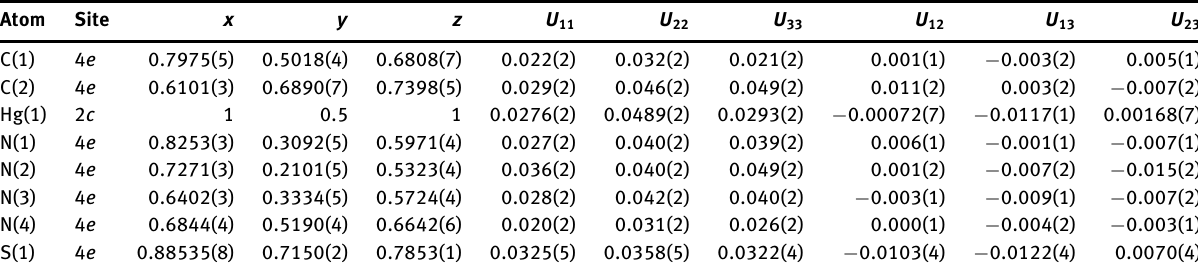
Table 3: Atomic displacement parameters (Å 2